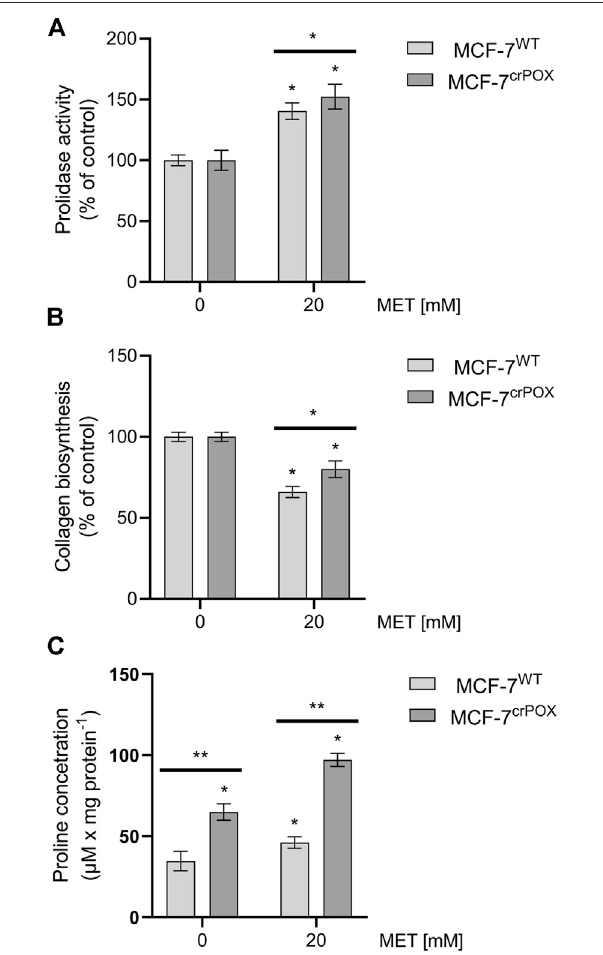
FIGURE 5 | Prolidase activity (A) , collagen biosynthesis (B) , and proline concentration (C) in wild-type MCF-7 cells (MCF-7 WT ) and knocked-down PRODH/POX MCF-7 cells (MCF-7 crPOX ) upon treatment with 20 mM metformin (MET) for 48 h in glutamine-free medium. The mean values with standard deviation (SD) from three experiments performed in duplicates are presented. Asterisks (*) indicate statistical differences between studied cells compared to controls at * p < 0.01 and ** p <